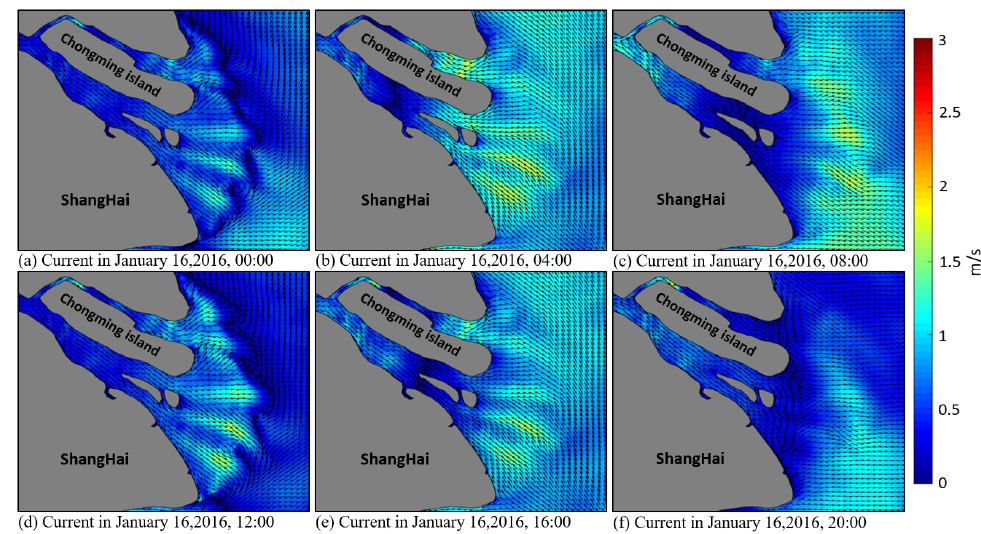
Figure 3. Simulated tidal current in the Yangtze River mouth on 16 January 2016.